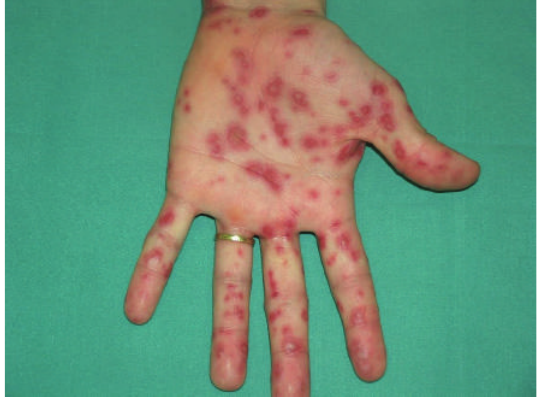
Figure 14: Erythema multiforme.